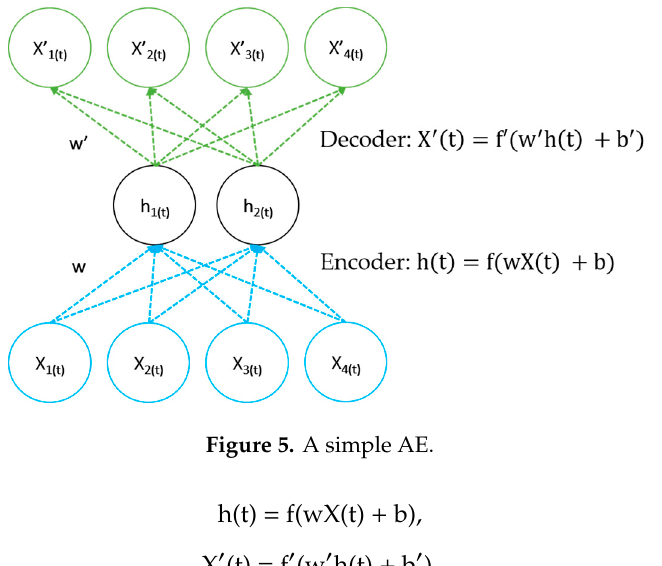
Figure 5. A simple AE.